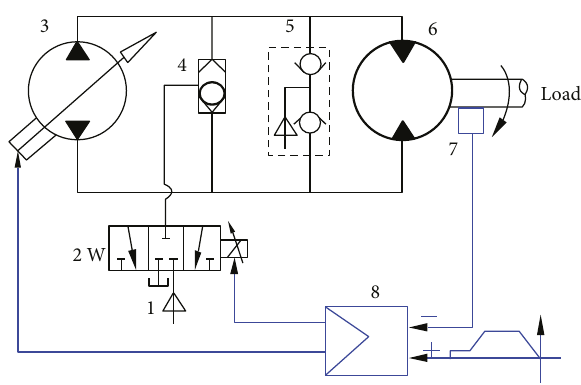
Figure 1: The schematic diagram of valve-pump parallel